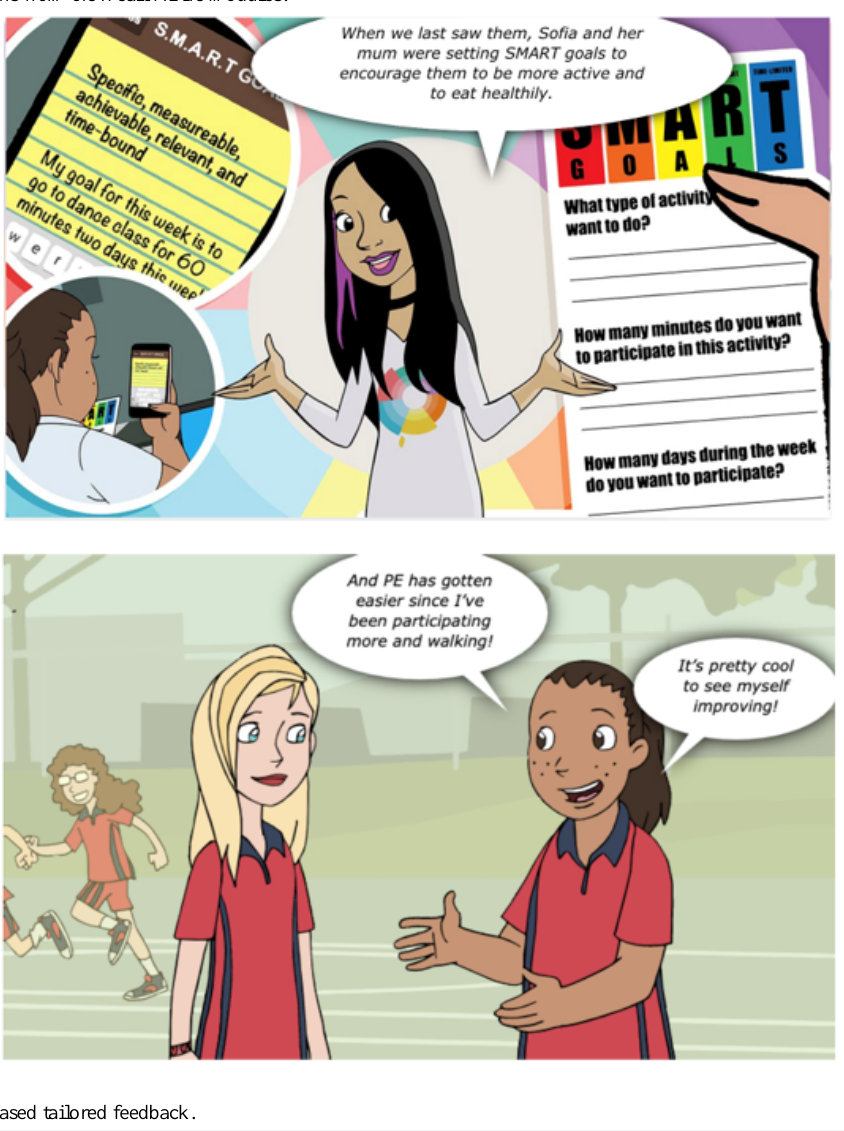
Figure 3. Example cartoons from the Health4Life modules.